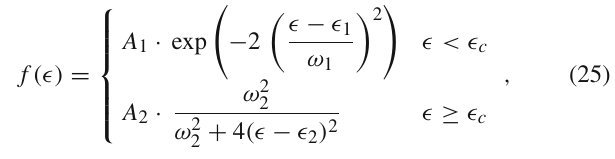
Fig. 7 Transmission function T at a retarding potential of U = 18 , 545 V with nominal magnetic field configuration ( B max The transmission condition in Eq. (20) relates the surplus energy to the pitch angle θ , as shown at the top of the figure. The solid red line shows the cut-off caused by a magnetic reflection of all electrons with high pitch angle in the strongest magnetic field at reference conditions B max = 6 . 0 . The dashed blue line shows the transmission function with- B S 3 . 6 out magnetic